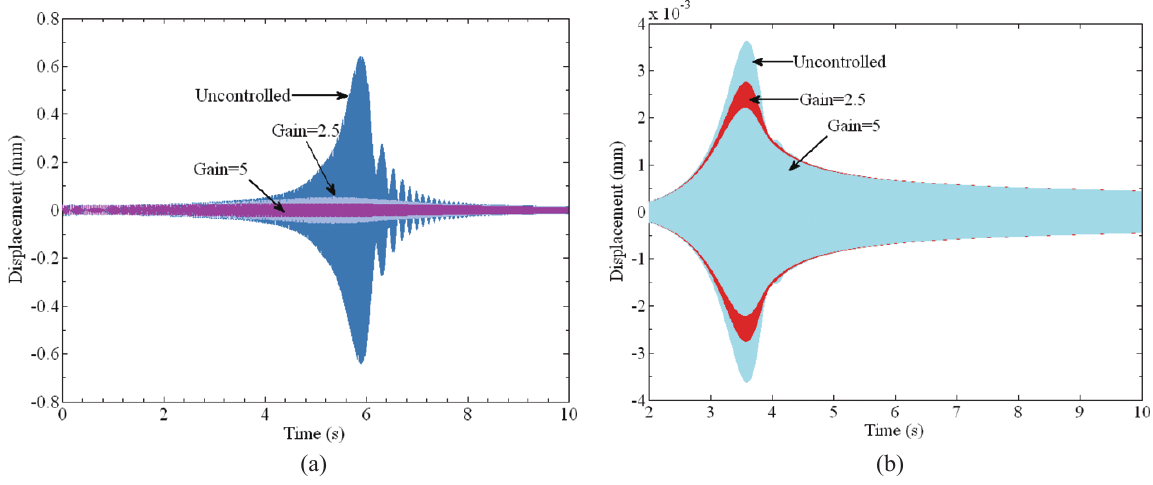
Fig. 10. (a). Response of the uncontrolled and controlled beam due to a swept sine signal of unit amplitude around its fi rst resonance; (b). Response of the uncontrolled and controlled beam due to a swept sine signal of unit amplitude around its second resonance. ˆ ¯ M = 8 × 10 5 k A/m is considered. The relative permeability of Neodymium dipole moment per unit volume) of magnet is taken as μ r = 1 in the fi nite element analysis. The magnetic fl ux lines obtained using ANSYS are shown in Fig.